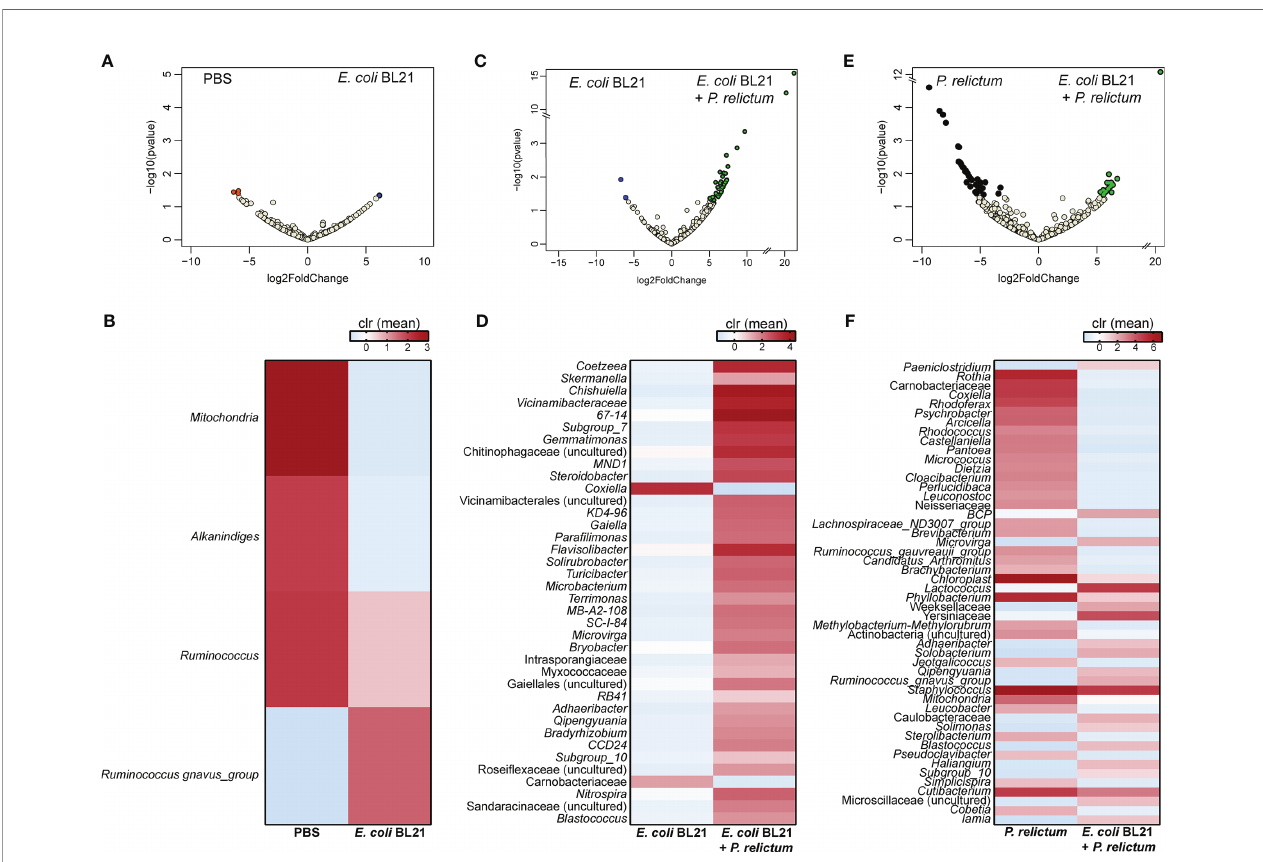
FIGURE 4 | Impact of E. coli BL21 vaccine and P. relictum infection on the taxonomic pro fi les of mosquito microbiota. Volcano plot showing the differential bacterial abundance in microbiota of mosquitoes from different experimental groups (A) PBS vs . E. coli BL21, (C) E. coli BL21 vs . E. coli BL21+ P. relictum , (E) P. relictum vs . E. coli BL21+ P. relictum. Taxa with signi fi cant differences (Wald test, p < 0.05) between the groups are represented with colored dots (i.e., orange, blue, green and black). The gray dots represent taxa with no signi fi cant differences between groups. Heatmaps represent the relative abundance (expressed as clr) of taxa with signi fi cant differences in the comparisons (B) PBS vs . E. coli BL21, (D) E. coli BL21 vs . E. coli BL21+ P. relictum , and (F) P. relictum vs . E. coli BL21+ P. relictum. Taxa with signi fi cant differences in their abundance were identi fi ed using DeSeq2 algorithm. The taxonomic pro fi les were obtained from 16S rRNA sequences from midgut of mosquitoes fed on mock-immunized (n = 5 mosquitoes midgut pool), E. coli BL21-immunized (n = 7 mosquitoes midgut pool), E. coli BL21-immunized and challenged with P. relictum (n = 7 mosquitoes midgut pool) and challenged only with P. relictum (n = 8 mosquitoes midgut